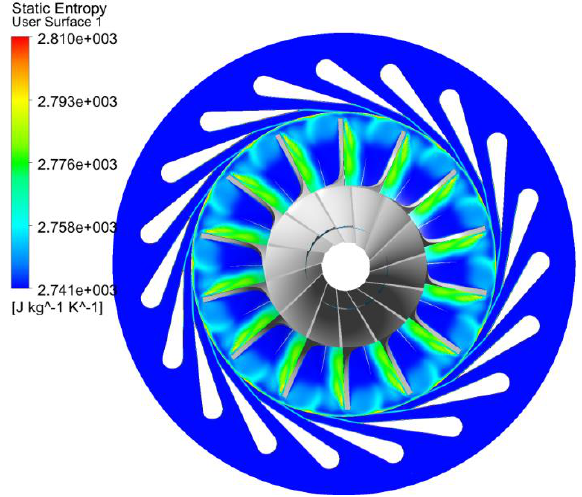
Figure 8. Example of specific entropy distribution in turbine stator and rotor. The contours are presented for design with specific speed of 0.45.